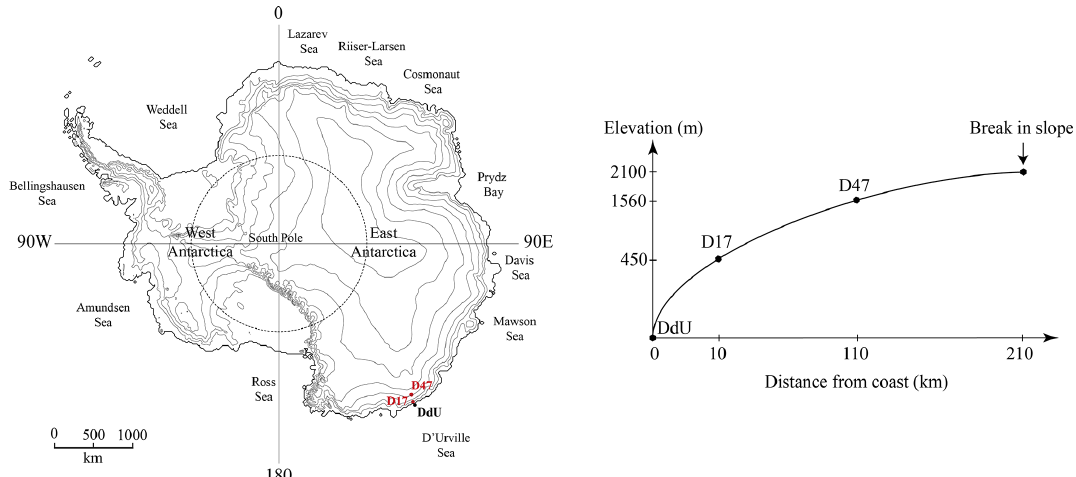
Figure 1. Location of Dumont d’Urville Station (DdU) and sites D17 and D47 in coastal Adélie Land and schematic cross section showing elevation and distance from the coastline for each site. Contours show elevation each 500m from 0 to